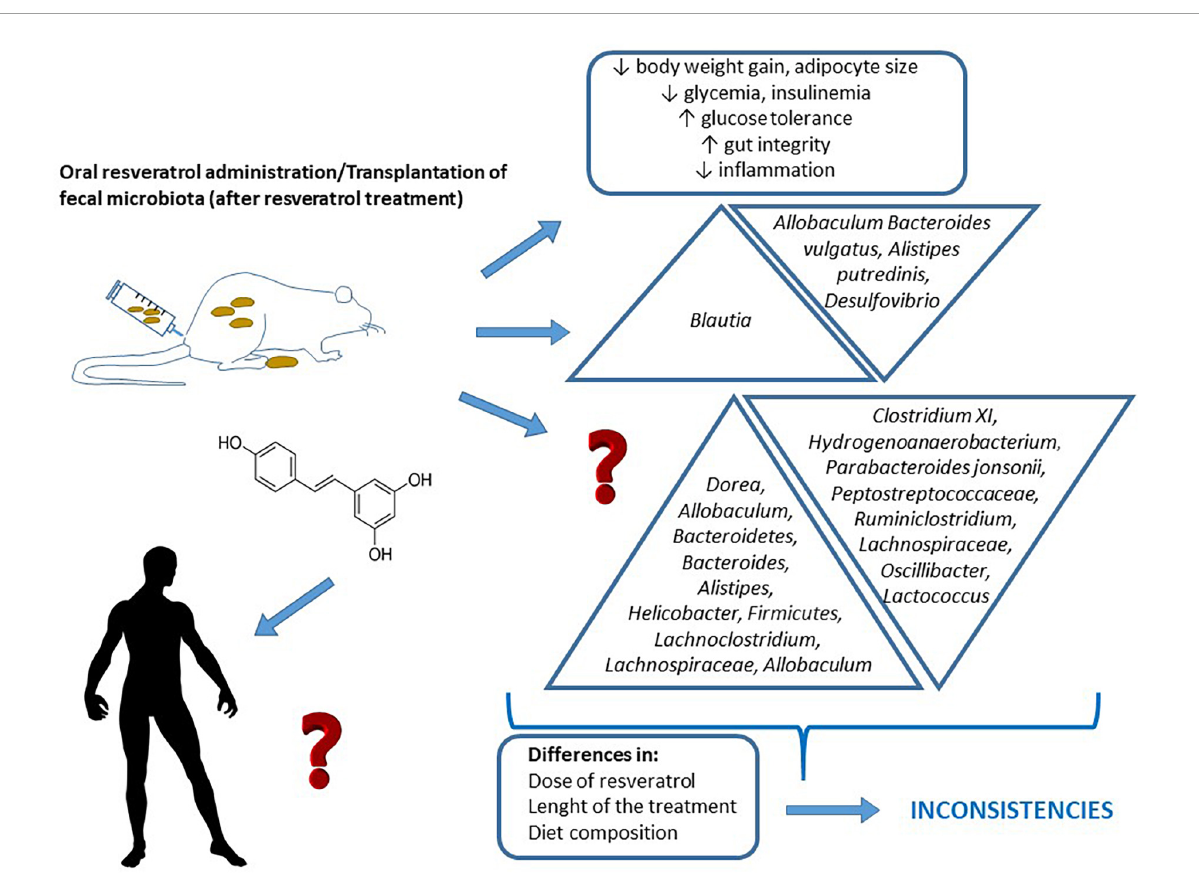
FIGURE1 Changes induced by resveratrol administration, or fecal matter transplantations from animals treated with resveratrol, on glycaemic control and gut microbiota composition. The figure also shows the differences among experimental designs that sometimes lead to insistencies in the obtained results, and the lack of studies addressed in